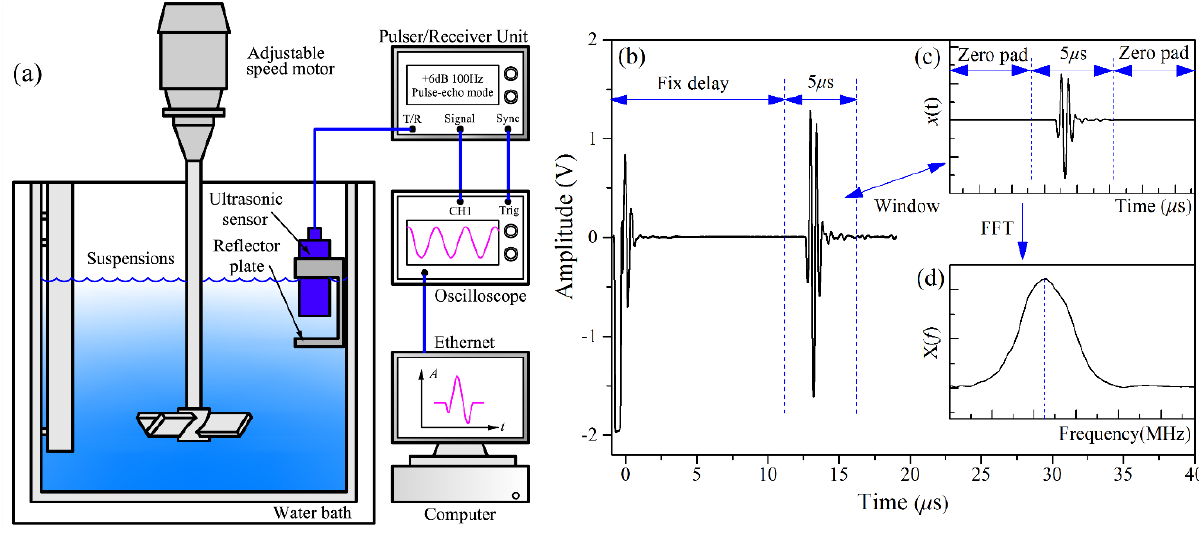
Figure 1. ( a ) Schematic diagram of the ultrasonic system for the measurement of suspensions concentration; ( b ) The full time domain signals of pure water; ( c ) The windowed, averaged and zero-padded time domain signals of ( b ); ( d ) The frequency spectrum of ( c